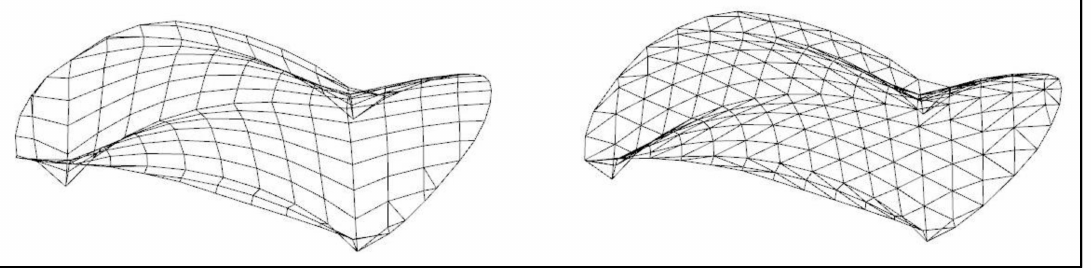
Figure 8. Geometries are generated according to Finding a 3-fixed number of joints (left–rectangular, right triangular). Both meshes present a smooth surface with less dense mesh (authors